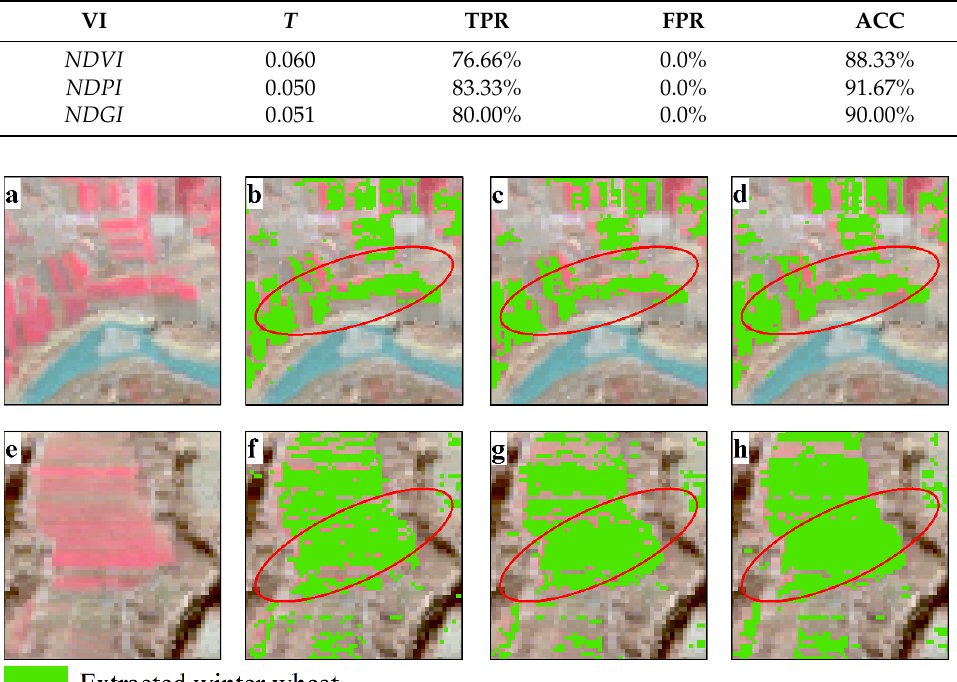
Figure 8. Partial distribution results of winter wheat: ( a – d ) are the extraction results of the Huangshui Valley area (representing discontinuous winter wheat coverage); ( e – h ) are the extraction results of the Yellow River Valley area (representing contiguous coverage); and panels from left to right are winter wheat results extracted by false color imaging, NDVI, NDPI, and NDGI, in this order.